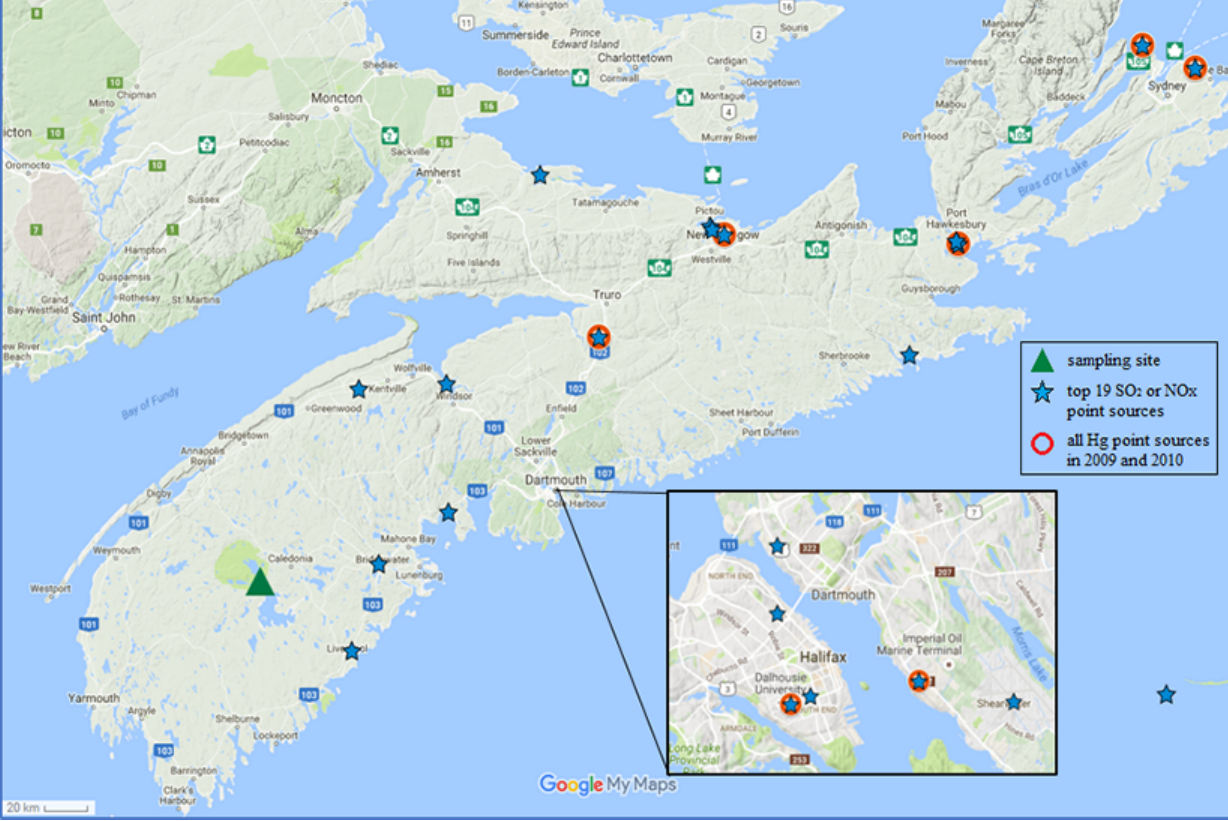
HNO 3 , PM 2 . 5 (2009 only), and particulate SO 2 − Mg 2 + , Cl − , K + , Ca 2 + , NH +